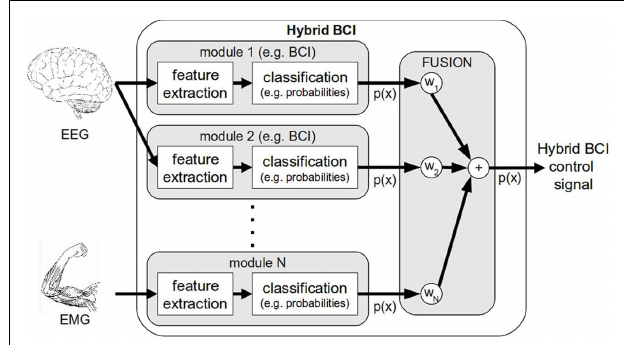
FIGURE 4 | Fusion principle of several BCI classifiers and one muscular channel to one hBCI control signal. p(x), probability; w1, w2, w3, weight of the fusion rule.